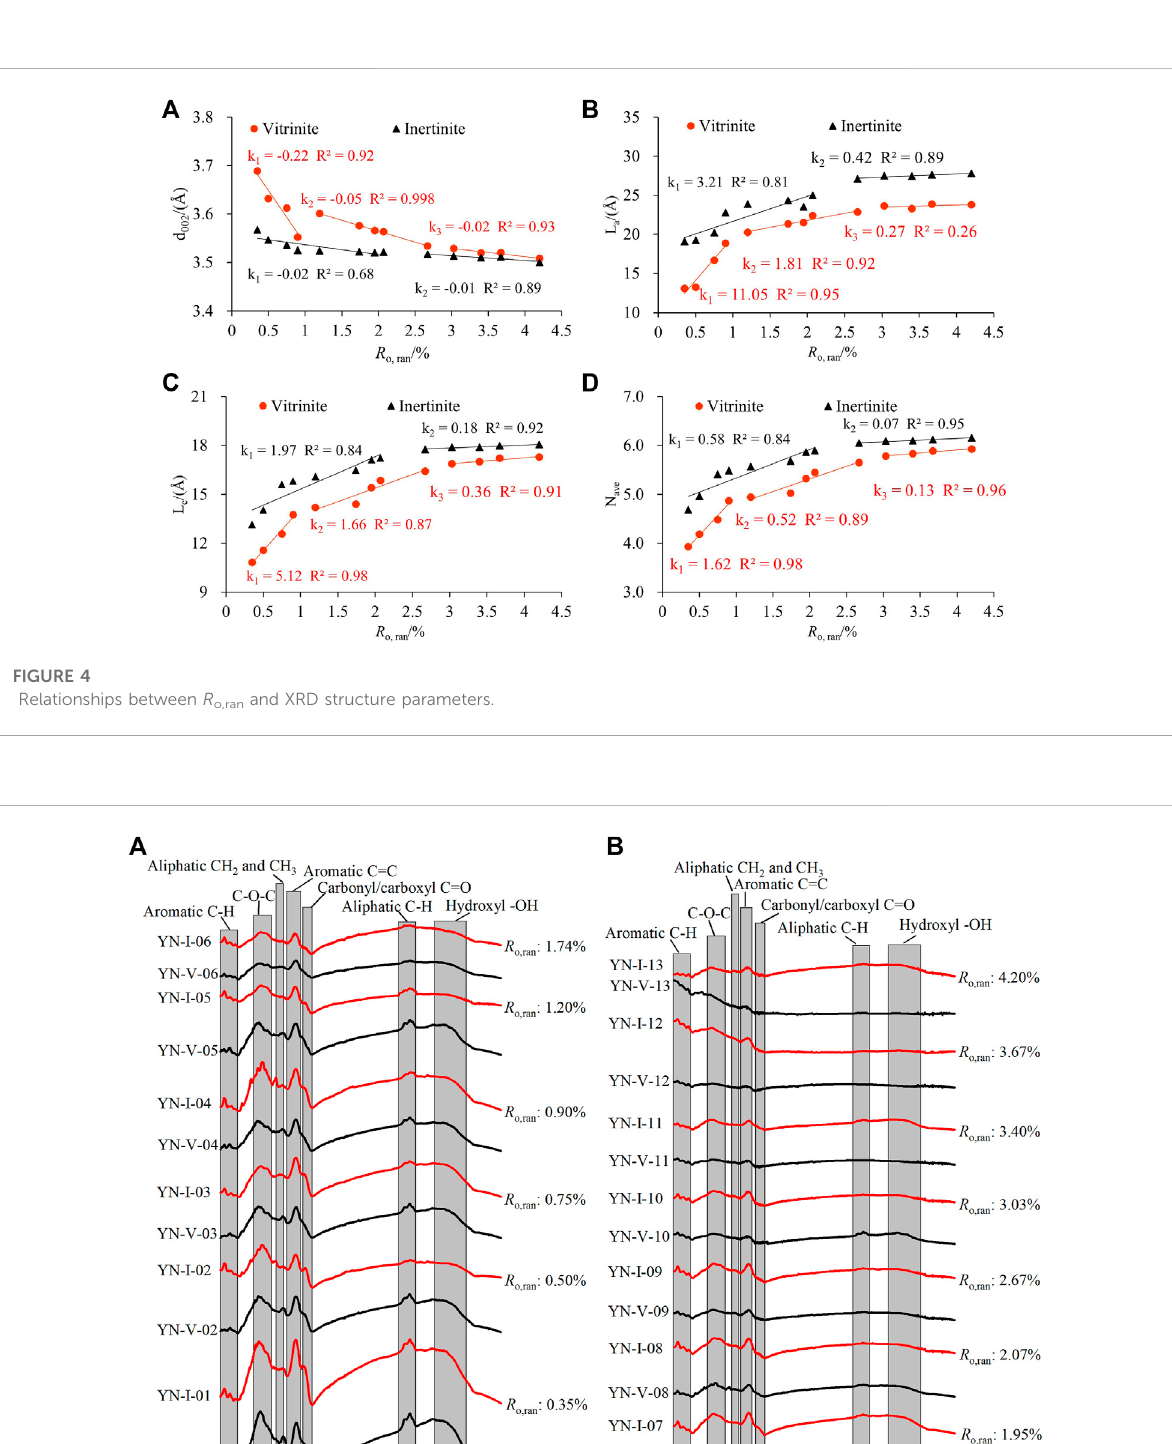
Frontiers in Earth